Question: Generate an informative caption for the figure above.
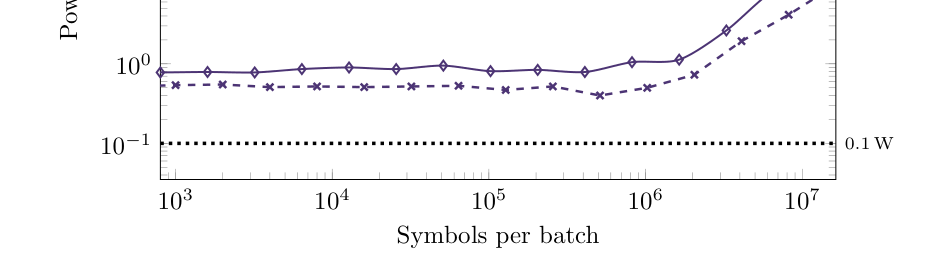
Answer: Comparison of the power consumption of the CNN-based equalizer, running on GPU, CPU and FPGA. PT refers to the PyTorch and TRT refers to the TensorRT models.